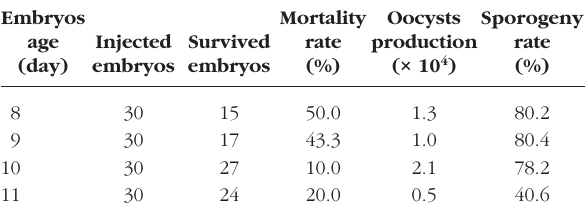
Table I. – The affect of embryo age for inoculation.